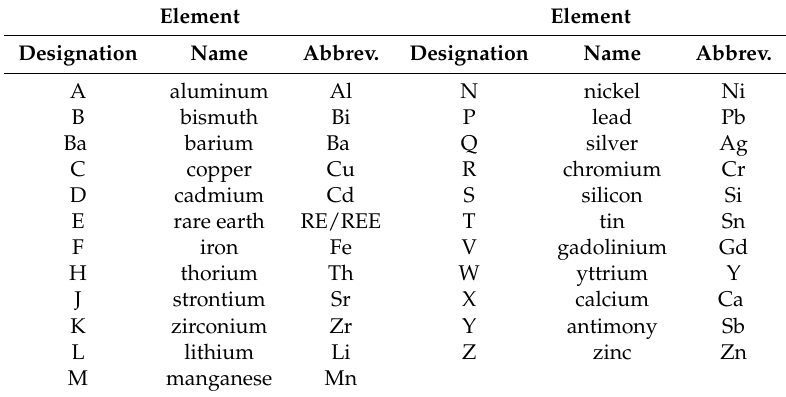
Table 1. Common alloying element designations based on the ASTM Standard Alloy Designation System. Element